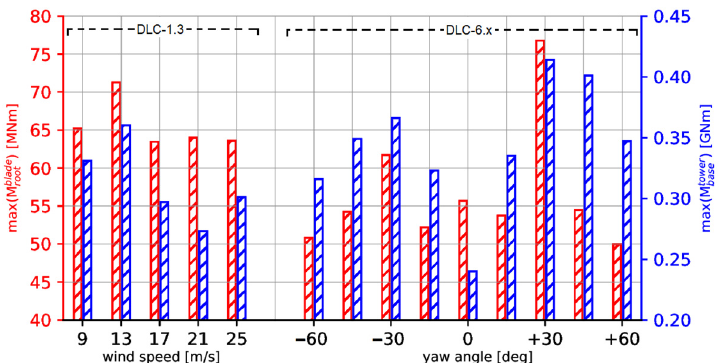
Figure 4. Maximum combined bending moment at blade root (red bars) and tower base (blue bars), for DLC-1.3 and DLC-6.x, for various wind speeds and wind yaw